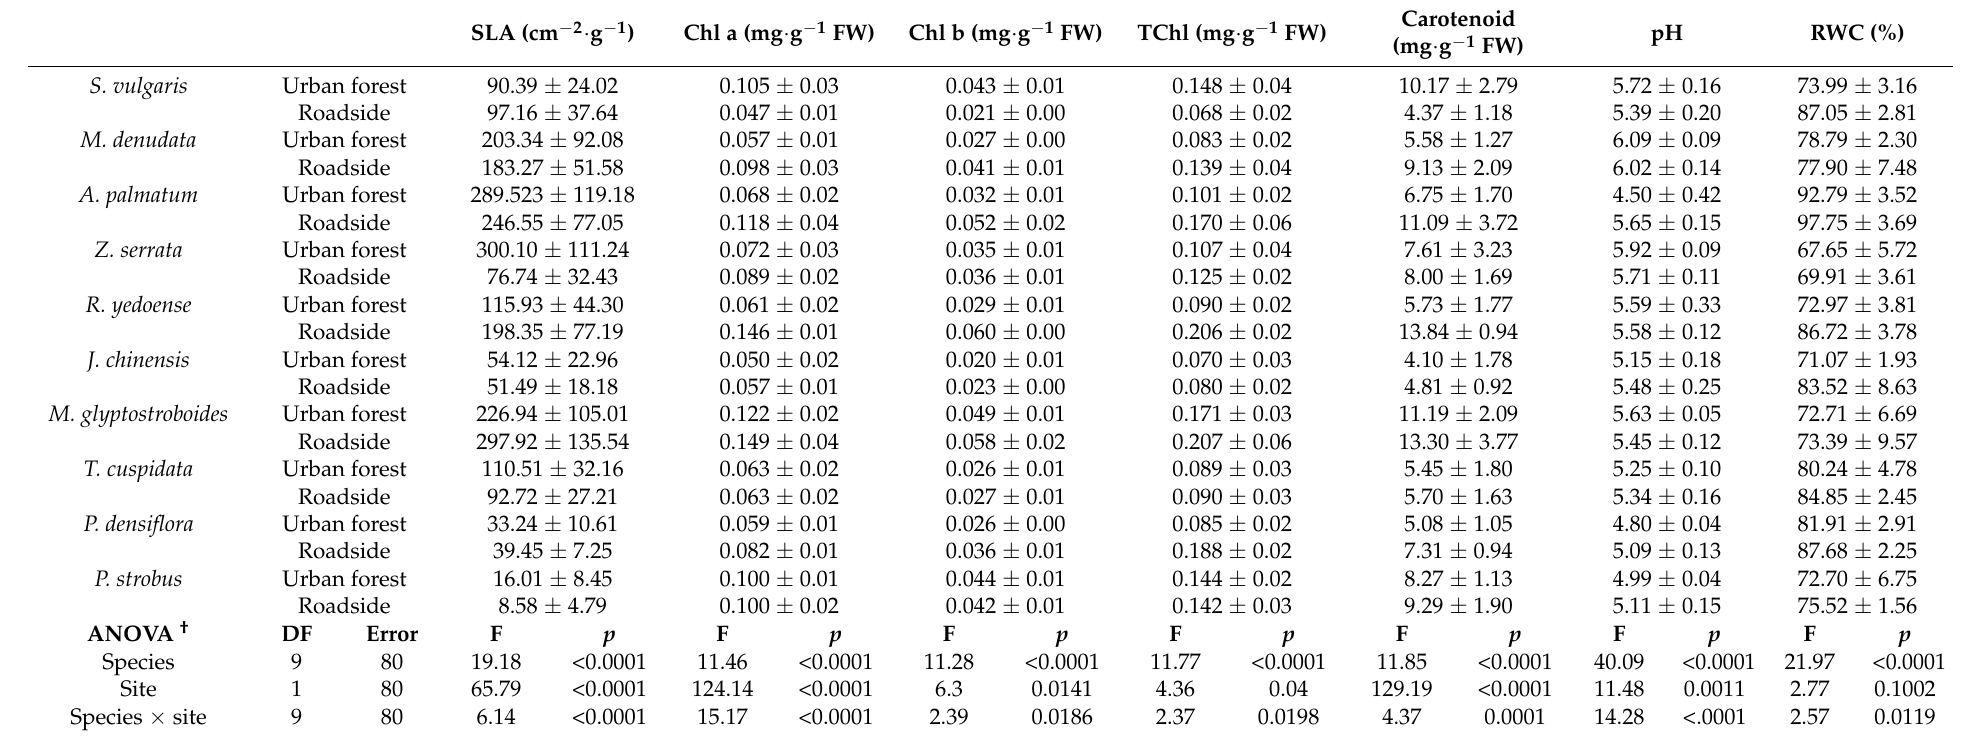
Table 3. Average leaf trait parameter values of 10 plant species at two different